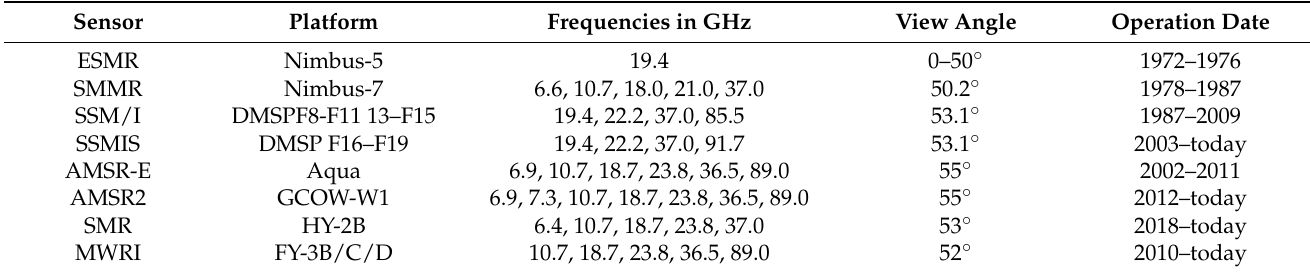
Table 1. An overview of satellite microwave sensors for monitoring sea